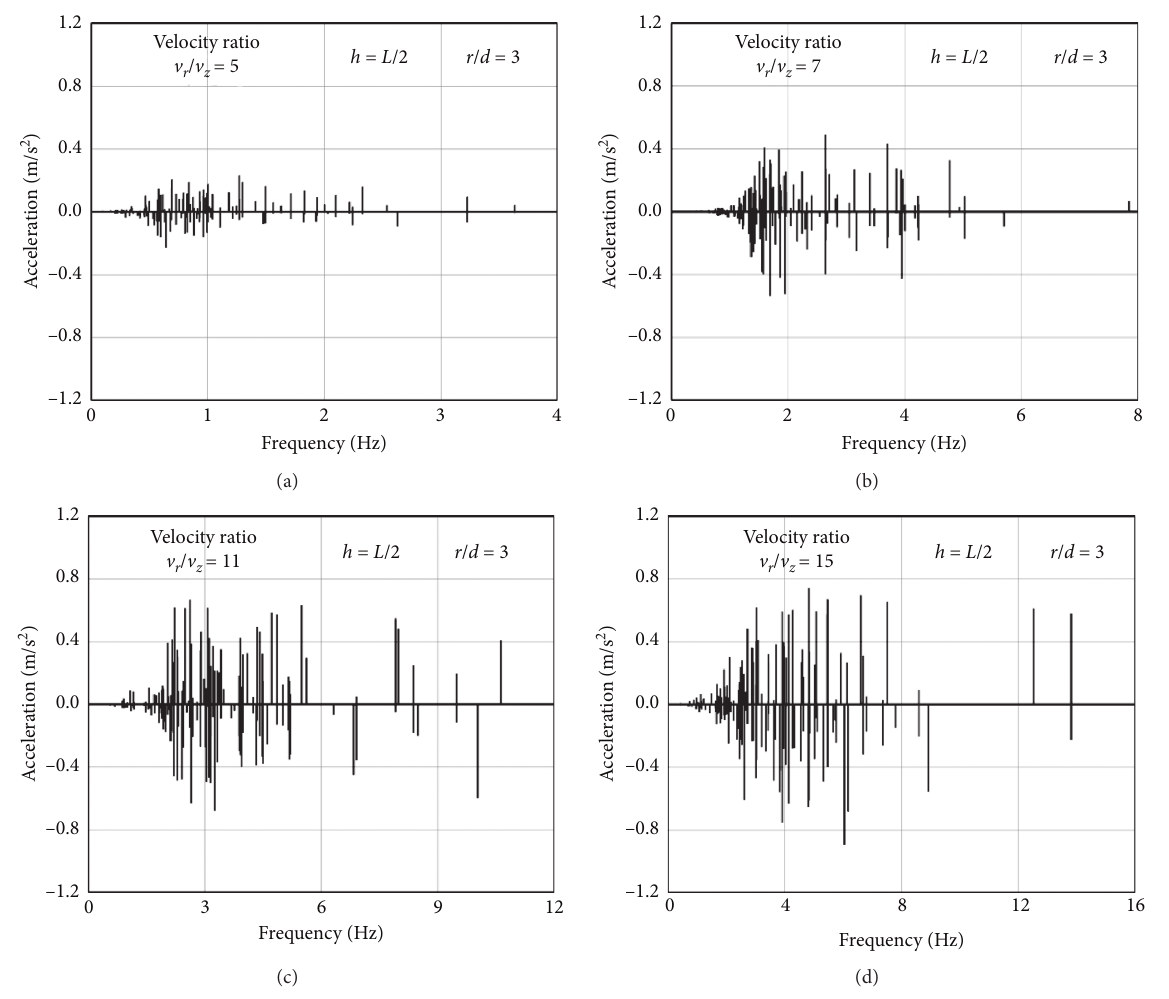
Figure 6: Acceleration amplitude and vibration frequency of the soil during drilling